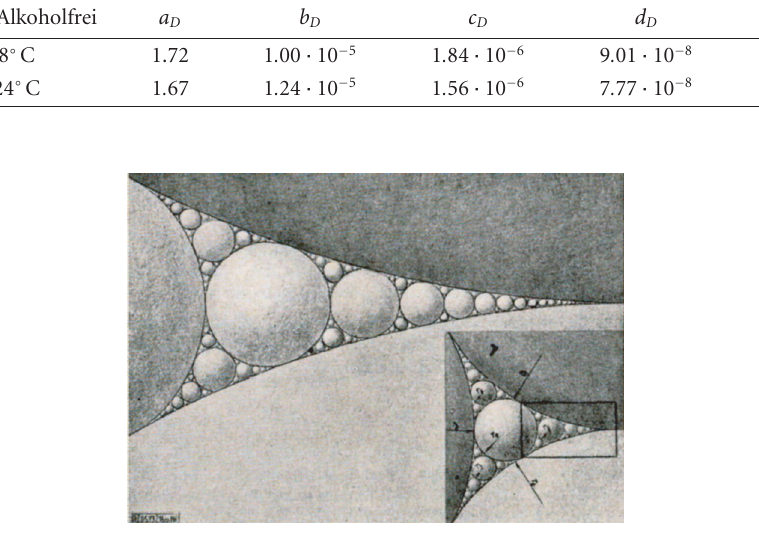
Figure 3.11. Apollonian spheres (this reproduction has been taken from [18]; the publishing house does not exist any